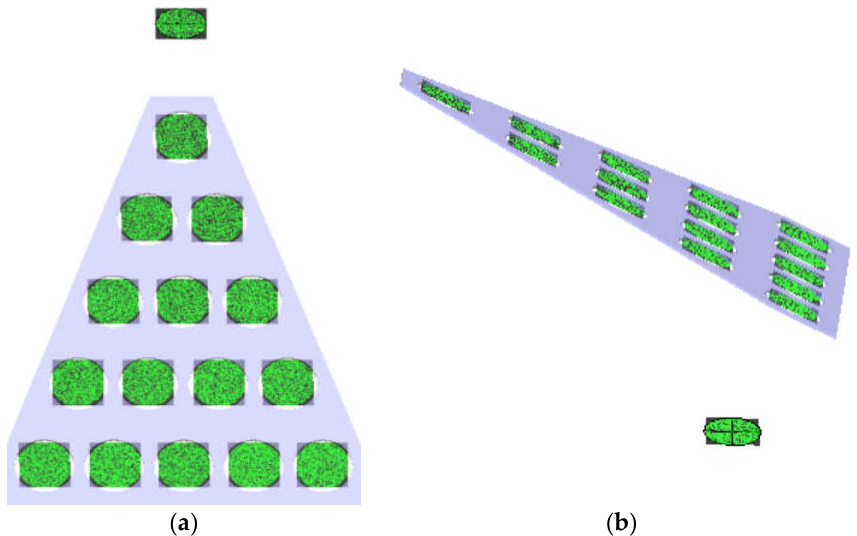
Figure 4. Geometric positions of optical monitoring and quartz monitoring systems ( a ) An optical monitoring component and coating substrate holder; ( b ) A quartz monitoring sensor and coating substrate holder (served as a receiver).